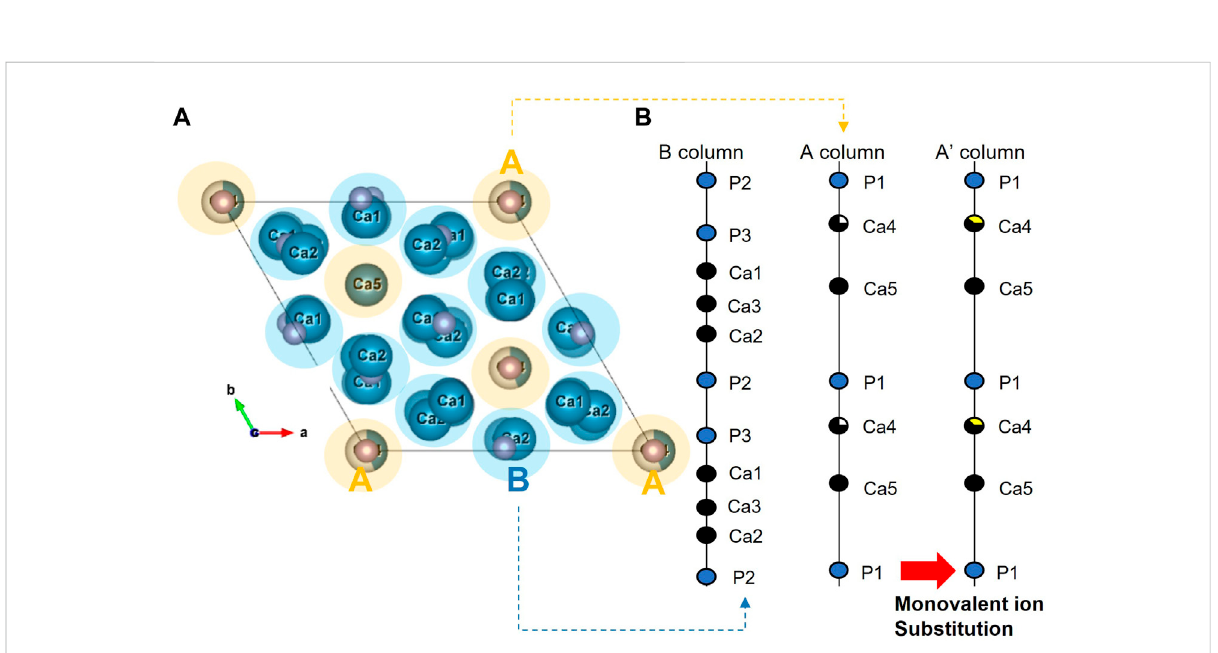
FIGURE 2 Lattice structure model of B-TCP from the view of (A) “ c ’’ axis and (B) along ‘‘ c ’’ axis.